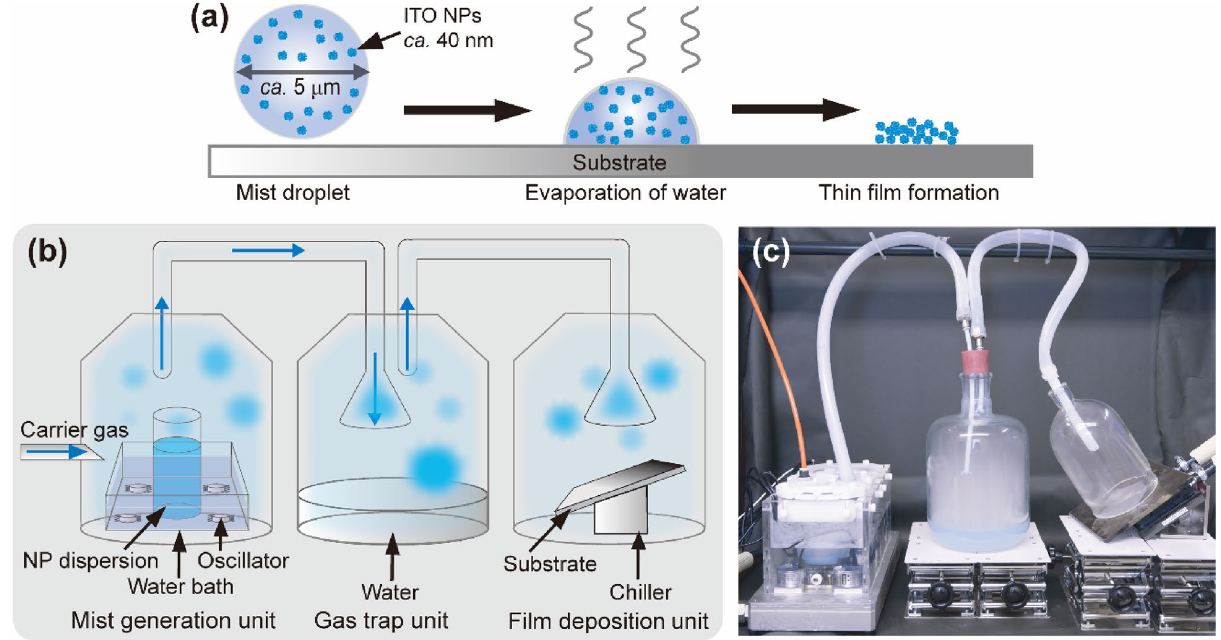
Figure 3. ( a ) Schematic image of the ITO NP-mist deposition mechanism on substrates. ( b ) Illustration and ( c ) photo of the setup for the ITO NP-mist deposition method developed in the present